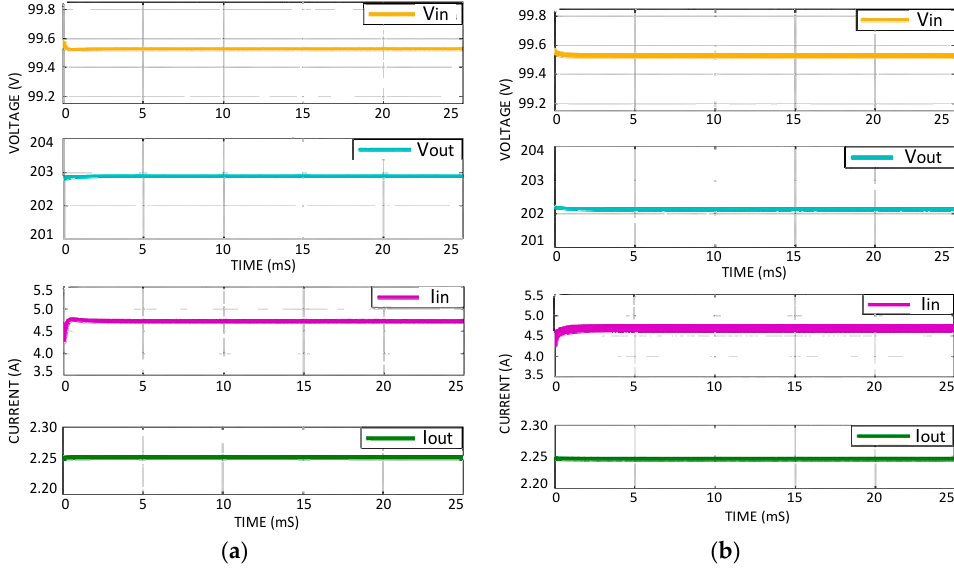
Figure 7. DC signals are measured in ( a ) 2-Level and ( b ) 3-Level converters. Table 2. Input and output voltages and currents for efficiency simulation in the converter and MFT.